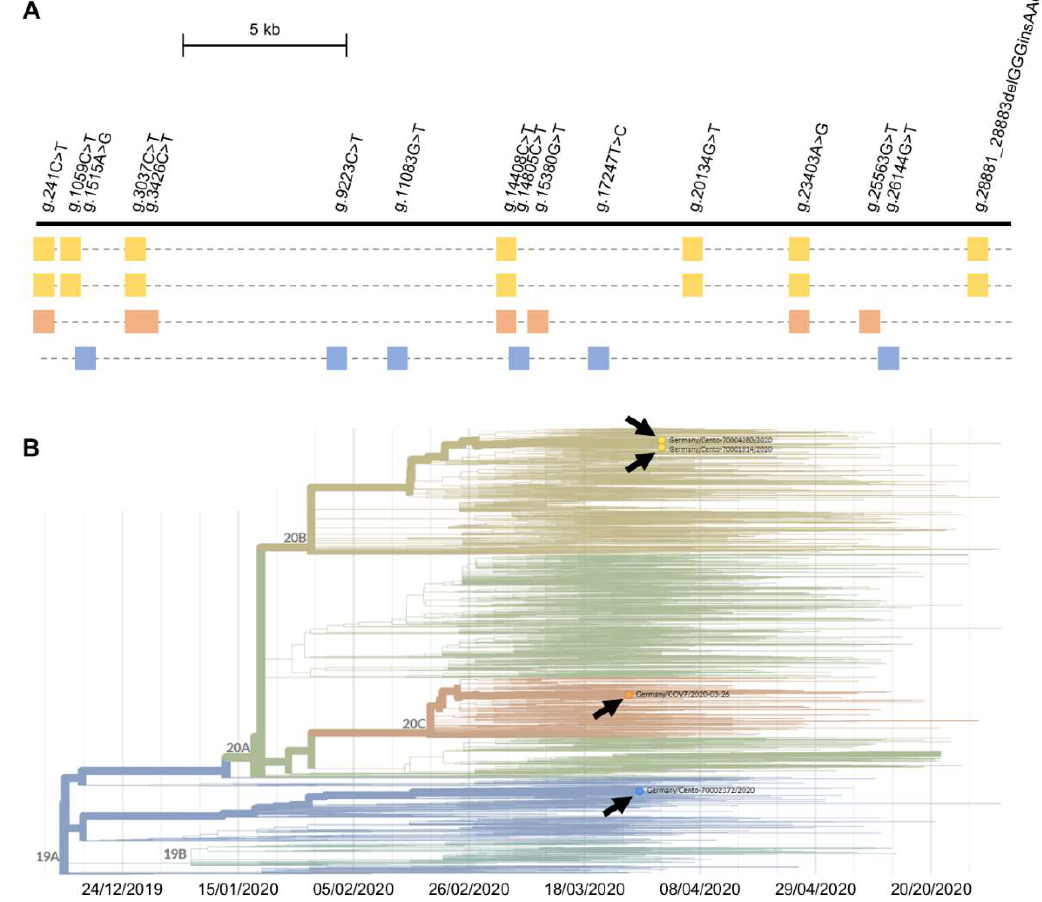
Figure 3. Genomes of the identified Severe Acute Respiratory Syndrome Coronavirus-2 (SARS-CoV-2) species. ( A ) To scale scheme of the 29,903 bp viral reference genome as a horizontal black line (NC_045512). Variants detected in at least one of the four sequenced specimens are indicated above; presence of the variant in question in a sample (samples as stippled horizontal lines) is indicated by a colored square. ( B ) Phylogenetic analysis of the four SARS-CoV-2 genomes (colors corresponding to those used in (A); image generated using tools as provided by Nextstrain [19]). 19A, 19B, 20A, 20B, and 20C denote the currently recognized five major clades; arrows indicate where the presently analyzed virus genomes map in the overall phylogenetic tree.